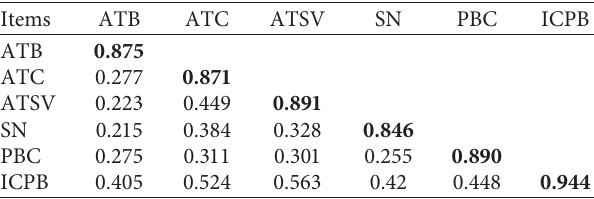
Table 5: Correlation matrix and the square root of AVE of factors. Items